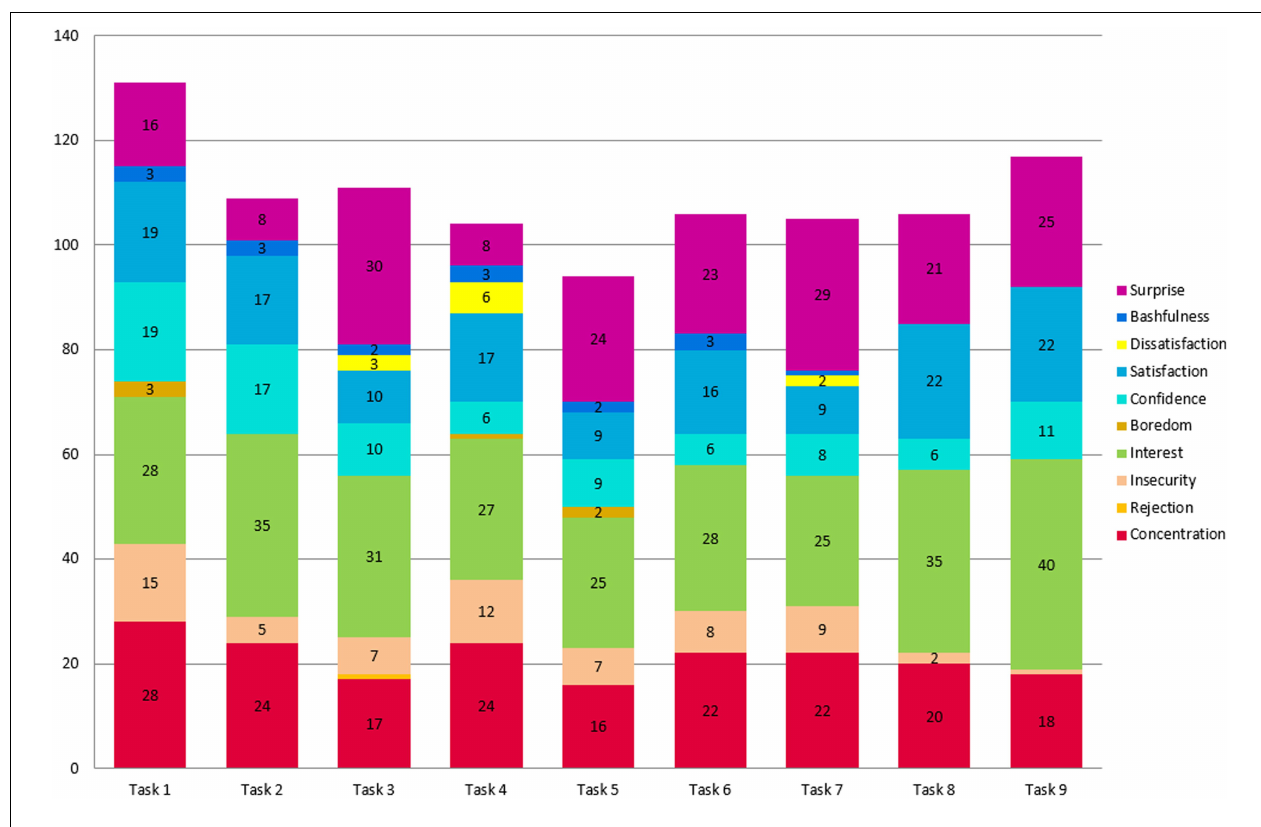
FIGURE 1 | Emotions experienced by the 45 participants of UAL and UMU. TABLE 2 | Correlations between knowledge declared by the 45 participants (posttest) and